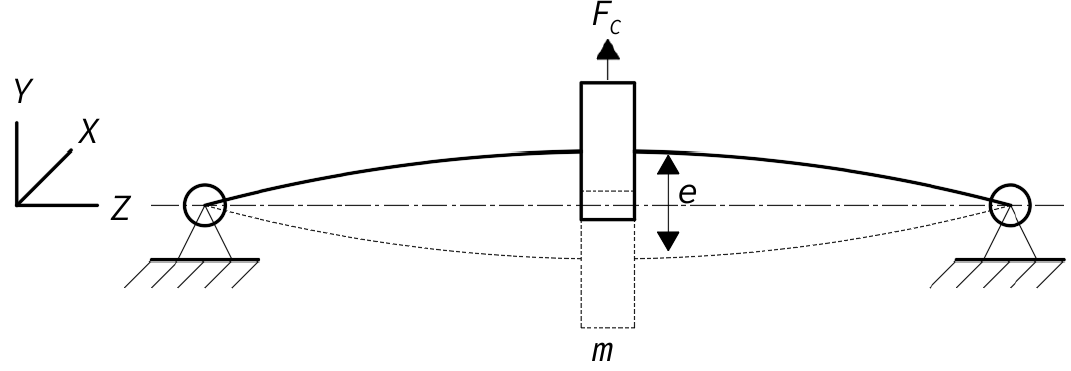
Figure 7. Model of a rotating coil.